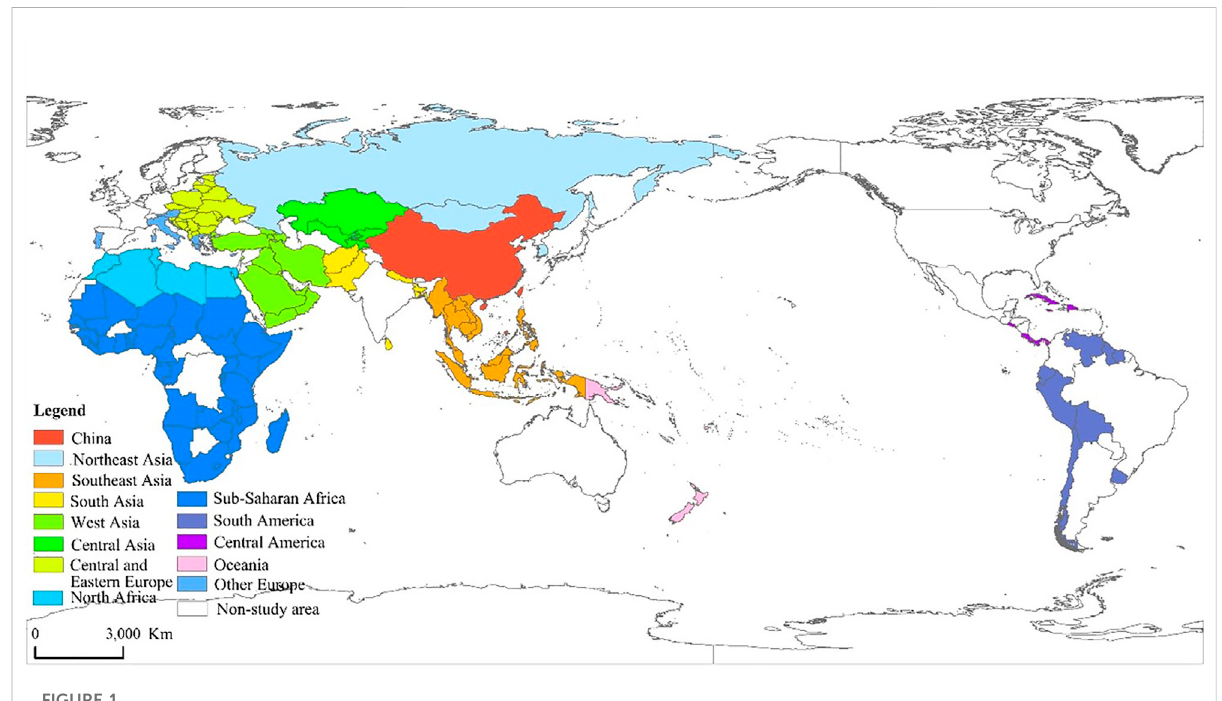
FIGURE 1 Regional classi fi cation of the Belt and Road